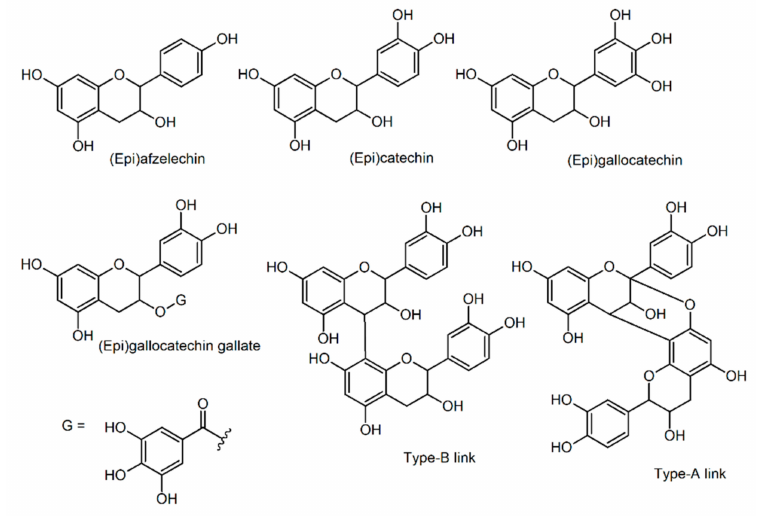
Figure 5. Simplified chemical structures of proanthocyanidin monomers and representation of the type-A and type-B